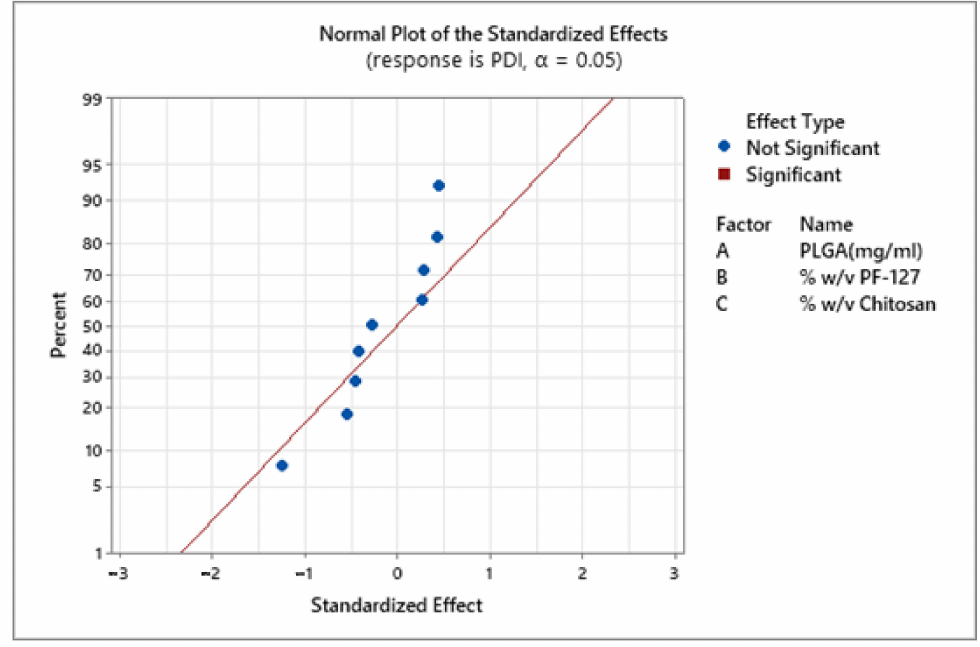
Figure 2. Effect of PLGA, PF-127 and chitosan on PDI of the prepared chitosan-coated PLGA nanoparticles. The blue points represent the insignificant factors.